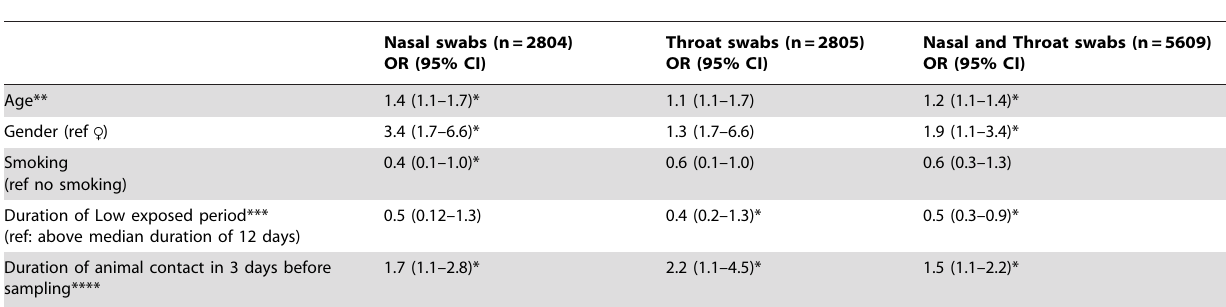
Table 3. Associations between MRSA nasal and throat carriage and determinants in a multiple regression analysis.